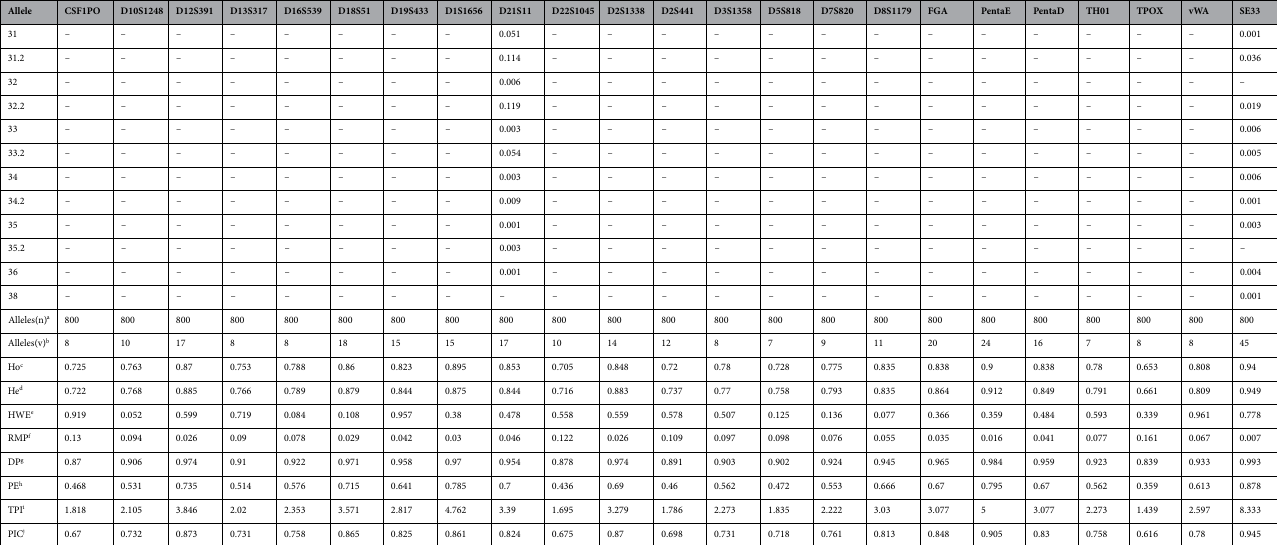
Table 1. Allele frequencies among 400 Kuwaiti individuals typed at 23 autosomal STR loci in the PowerPlex Fusion 6C kit. a Number of alleles surveyed, b number of different allelic variants, c observed heterozygosity, d expected heterozygosity, e Hardy–Weinberg Equilibrium test ( p value), f random match probability, g discrimination power, h power of exclusion, i typical paternity index, j polymorphic information content.